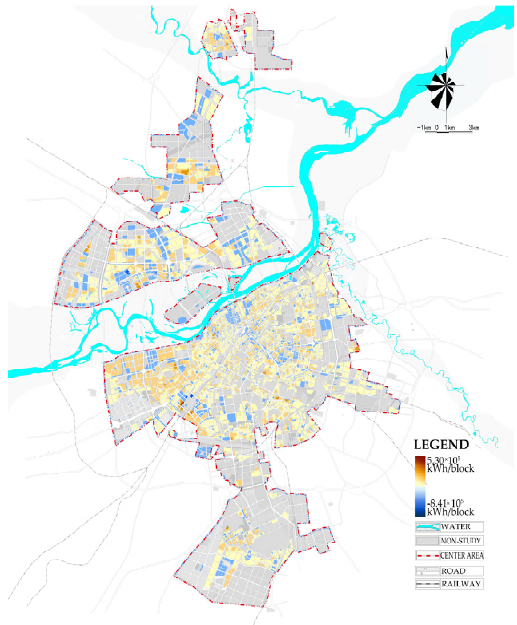
Figure 13. Changes in building energy consumption under the climate scenario over the next 50 years. Note: The term block refers to the grids mentioned in Section 2.2.2, and the area of each block is about 10 5 m 2